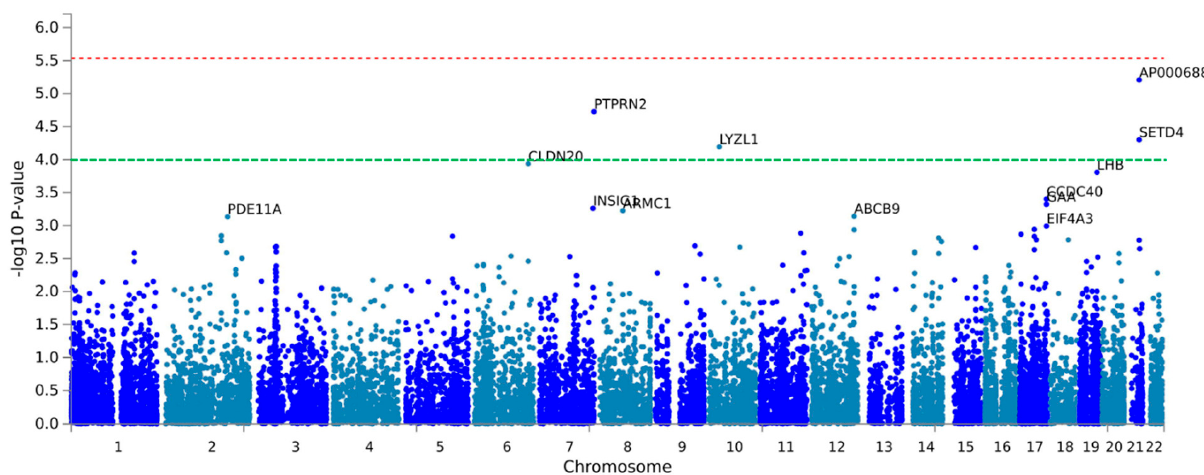
Figure 5. Manhattan plot for the GWAS analysis for sweet taste preference (as a dichotomous variable) in the whole population using a gene-based approach (adjusted for sex and age). We used MAGMA for computations in the FUMA platform. The top-ranked genes were annotated. The red line at 5.56 represents the threshold 1 ( − log 10 (2.7 × 10 − 6 )) for the gene-set analysis considering the strict Bonferroni correction. Likewise, the green line at 4.00 represents the threshold 2 ( − log 10 (1 × 10 − 4 )).